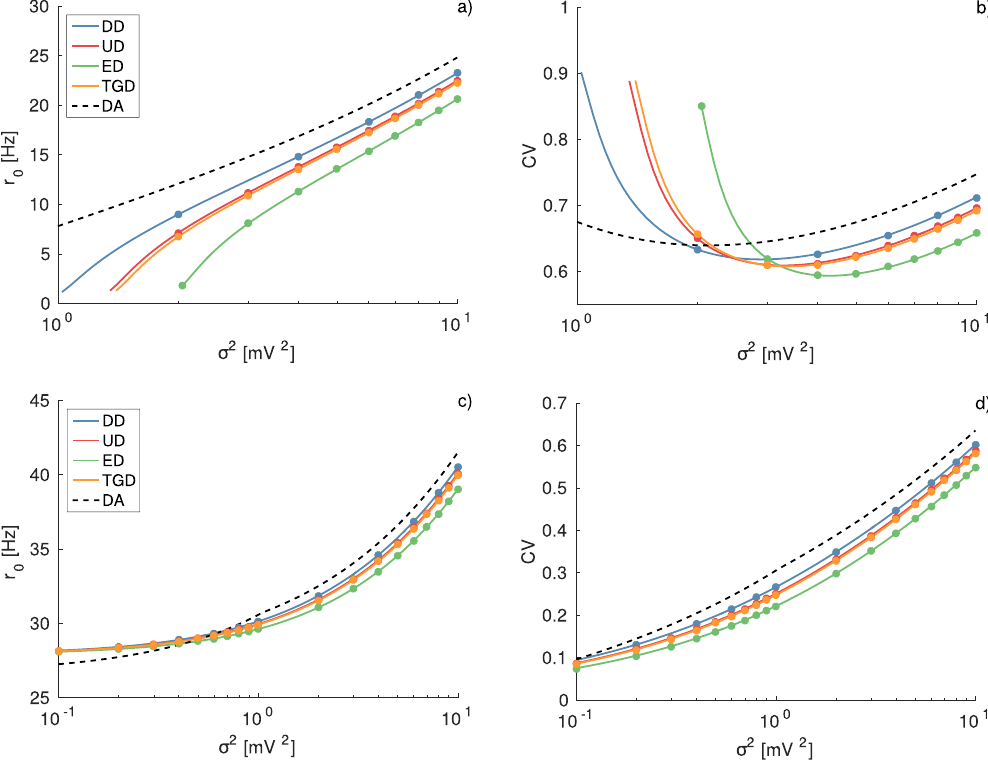
Figure 2. Firing time statistics for different IPSP distributions. Firing rate r 0 and CV as a function of noise intensity for sub-threshold ( μ T = 9 mV) ( a , b ) and supra-threshold neurons ( μ T = 11 mV) ( c , d ). In all the panels the symbols correspond to numerical simulations, the dashed black lines to the DA, calculated from Eqs (53) and (54), and the solid lines to the theoretical results reported in Eq. (17) and Eq. (27). The average IPSP amplitude is set to 〈 | a i | 〉 = 1 mV for all the distributions. For the TGD: the peak position | a p | and the width ≈ 0.7766 mV). For the UD: l = 2 a = 0. Other parameters and σ G of the distribution are equal (namely, 1 i and l 2 simulation procedures as in Fig. 1.